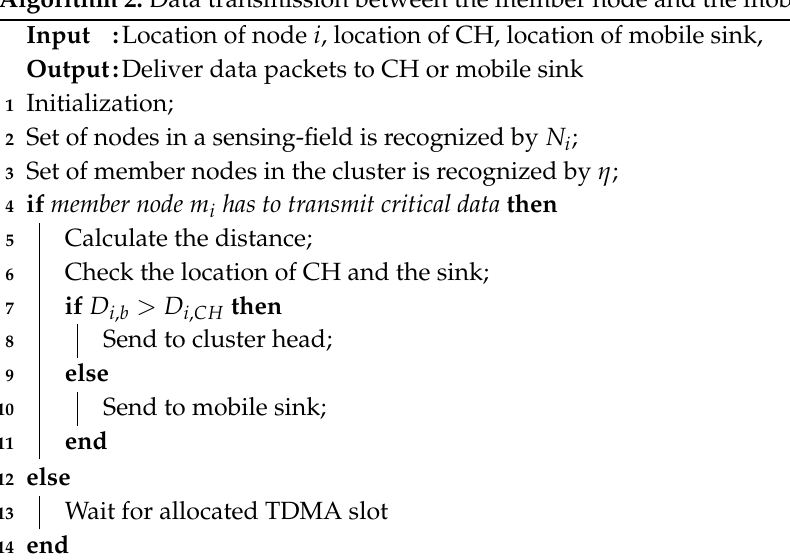
Algorithm 2: Data transmission between the member node and the mobile